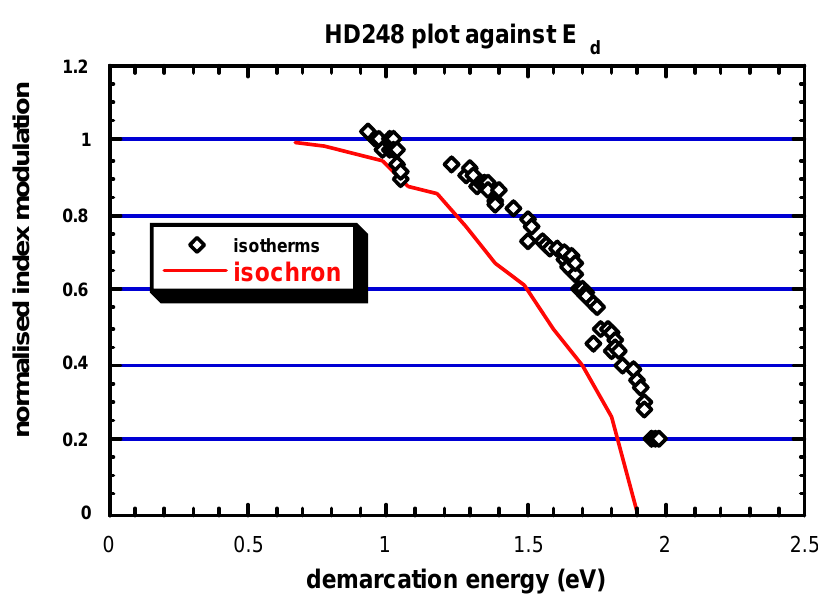
Figure 32. Plot of results of Figure 31 against k B T ln t .